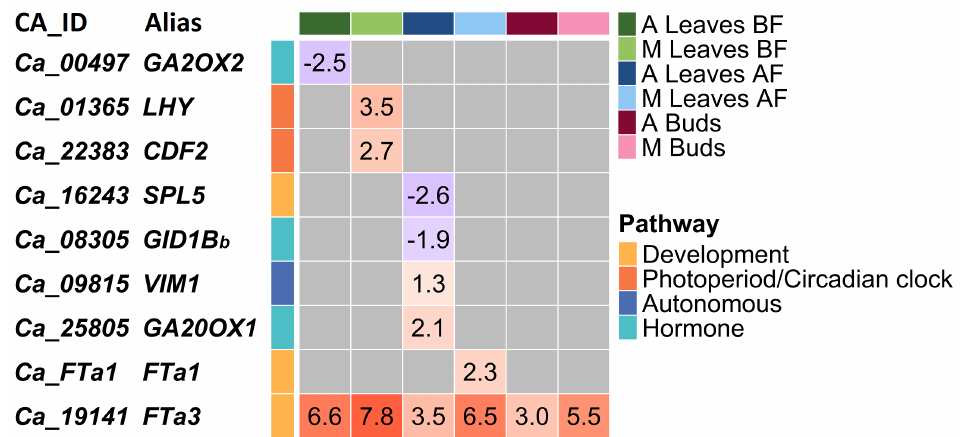
Figure 3. Changes in gene expression in cultivated chickpea in response to vernalization. Each comparison was analyzed in three tissue types (leaves BF, leaves AF and buds) and in the following species/accessions: ‘A’— C. arietinum , ‘M’—ICCV 96029 mutant, ‘R’— C. reticulatum , and ‘E’— C. echinospermum . The heatmap shows the FC values for differential expression of the genes listed in the right-hand panel. Up- and downregulation are shown in red and blue, respectively. Gray cells indicate the absence of differential expression between tissue types. FTa3 is upregulated by vernalization in both C. arietinum and mutant ICCV